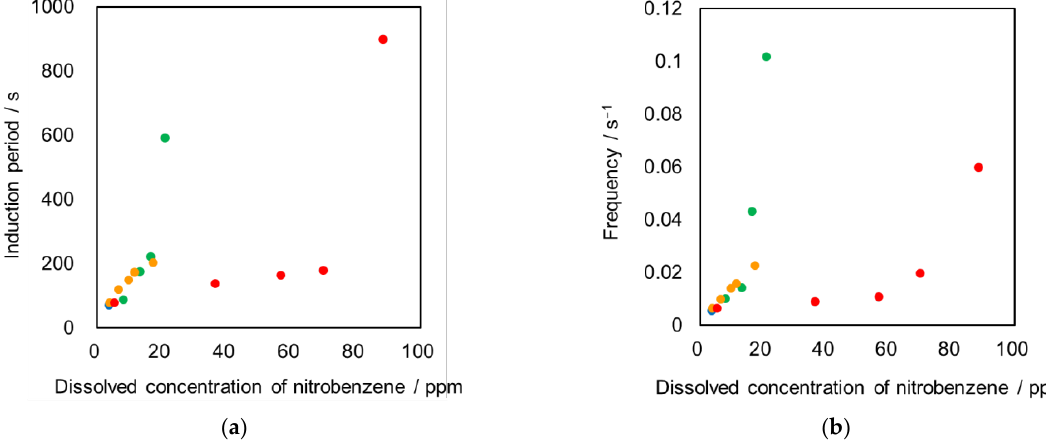
Figure 5. Relation between concentration of nitrobenzene dissolved in aqueous phase and the oscil- lation characteristics; ( a ) induction period and ( b ) frequency; Each symbol indicates the additive